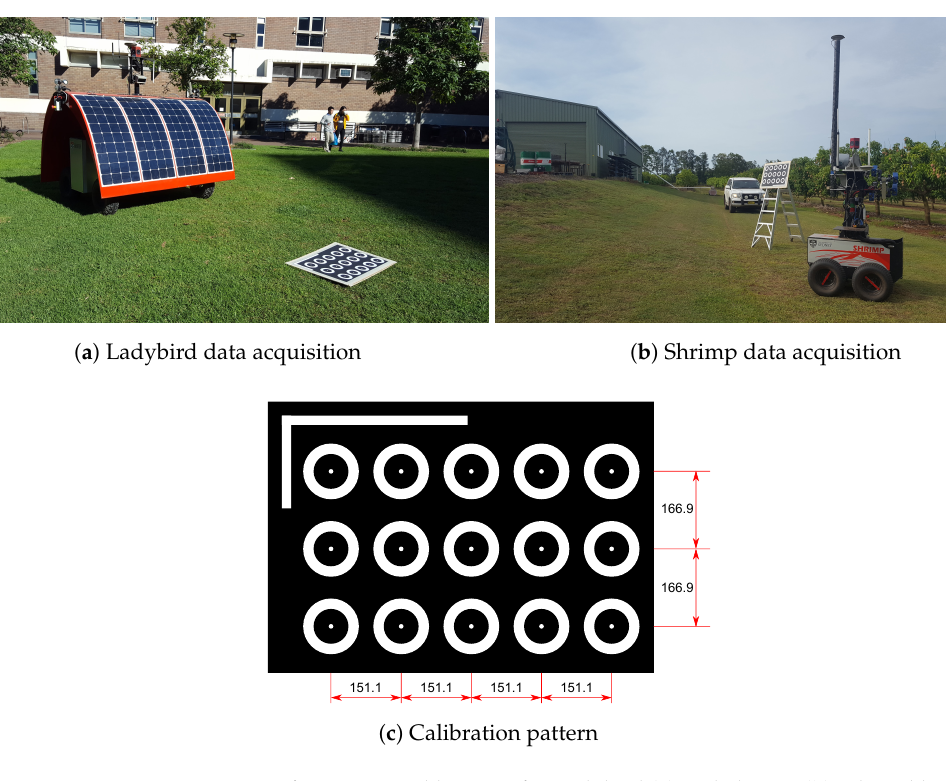
Figure 4. Data acquisition configuration and location for Ladybird ( a ) and Shrimp ( b ). The calibration pattern used in both instances is shown in ( c ). Dimensions are in mm. The centre dots are 10 mm in diameter, sized to be as small as possible while still being visible in the image data in order to maximise labelling accuracy. The outer rings help with locating the points in the data for labelling, and are 75–120 mm, inner to outer diameter. Note that these dimensions do not need to be known for the optimisation procedure, nor is it necessary to print them in any particular strict arrangement, though a regular pattern is recommended to allow easy identification of each